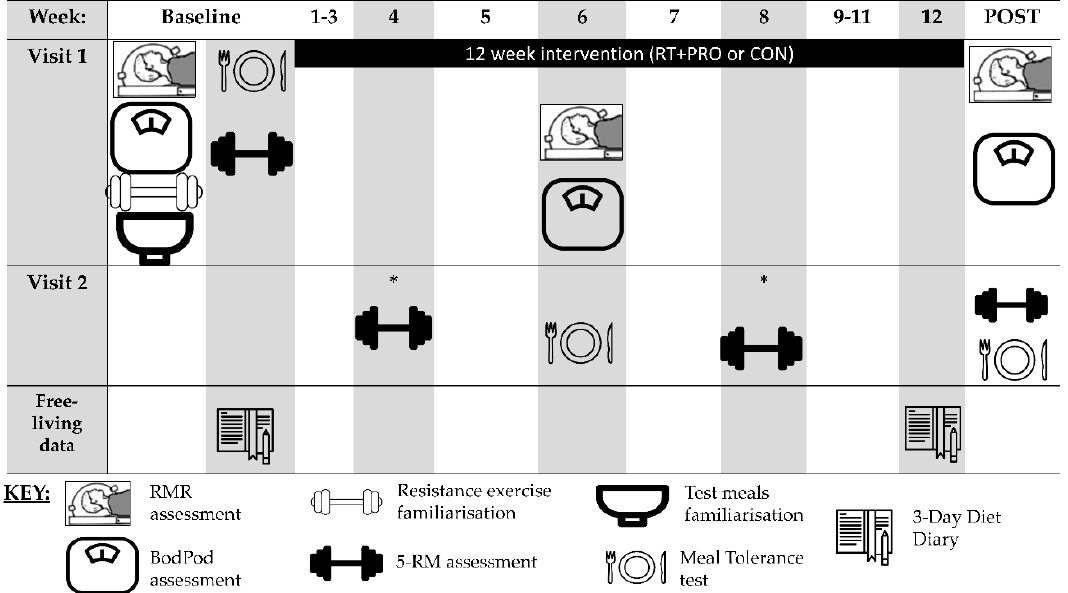
Figure 2. Schematic of the full randomised control trial including intervention and testing days. Participants were assigned to either the RT + PRO or CON during weeks 1–12. * indicates measures taken in RT + PRO only to adjust for training load.